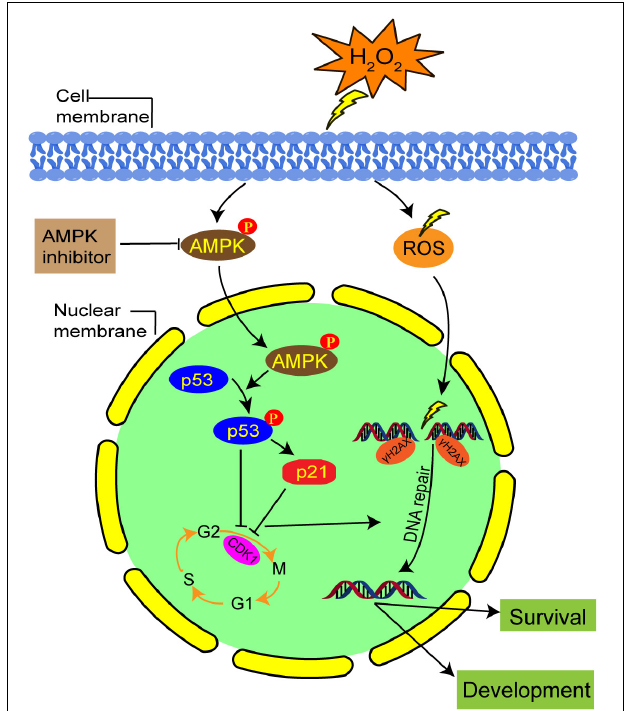
FIGURE 8 | Schematic representation of the AMPK-mediated G2 arrest regulation and DNA damage in mouse zygotes under mild oxidative stress. Oxidative stress activated AMPK first in the cytoplasm, which is subsequently translocated in the nucleus. AMPK activation contributes to oxidative stress-induced G2 arrest, by inhibiting CDK1 activity via the upregulation protein level of p53 and p21. The G2 arrest facilitates DNA damage repair and the development and survival of oxidative stress-damaged